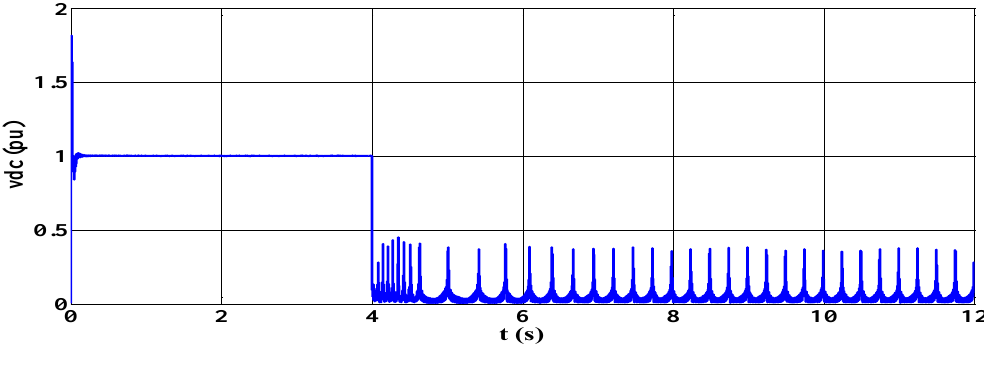
Figure 25. DC link voltage (short-circuit happens at t = 4 s).